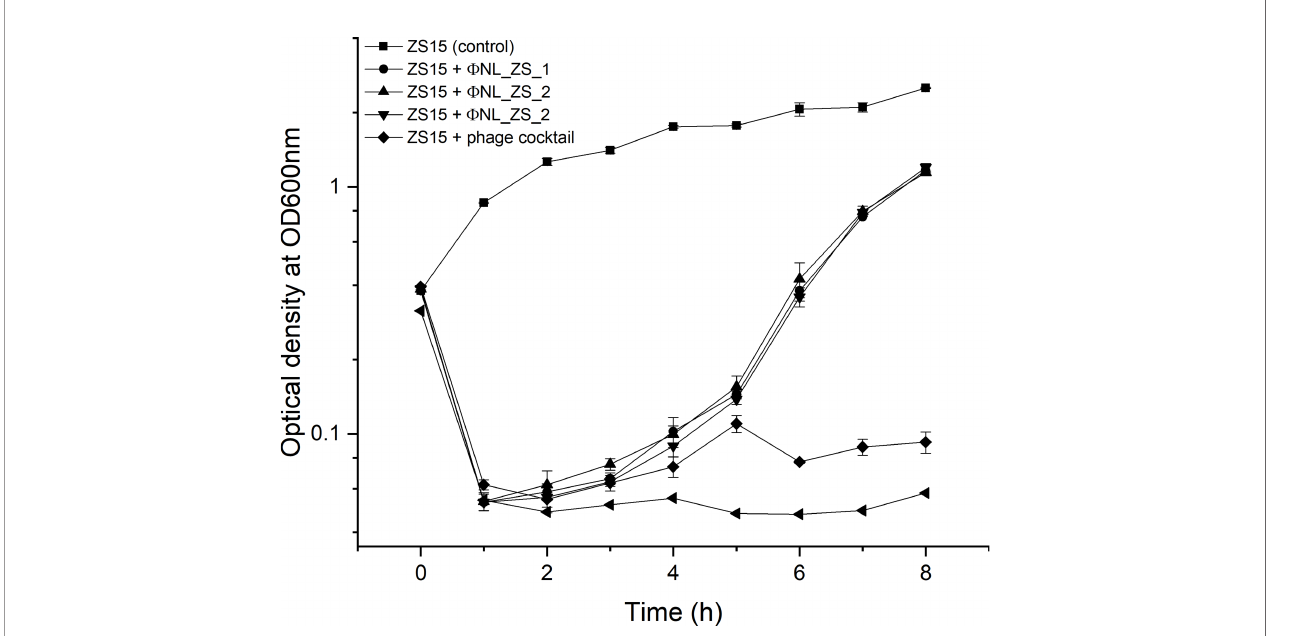
FIGURE 6 | Inhibition assay of single phages and phage cocktail (NL_ZS_1, NL_ZS_2, and NL_ZS_3) in the treatment at a MOI of 0.1 and control without phage in cultures of K. pneumoniae ZS15. Optical density (OD600) was measured at 1-h intervals over an 8-h incubation period. Error bars represent the standard deviations from all experiments, carried out in